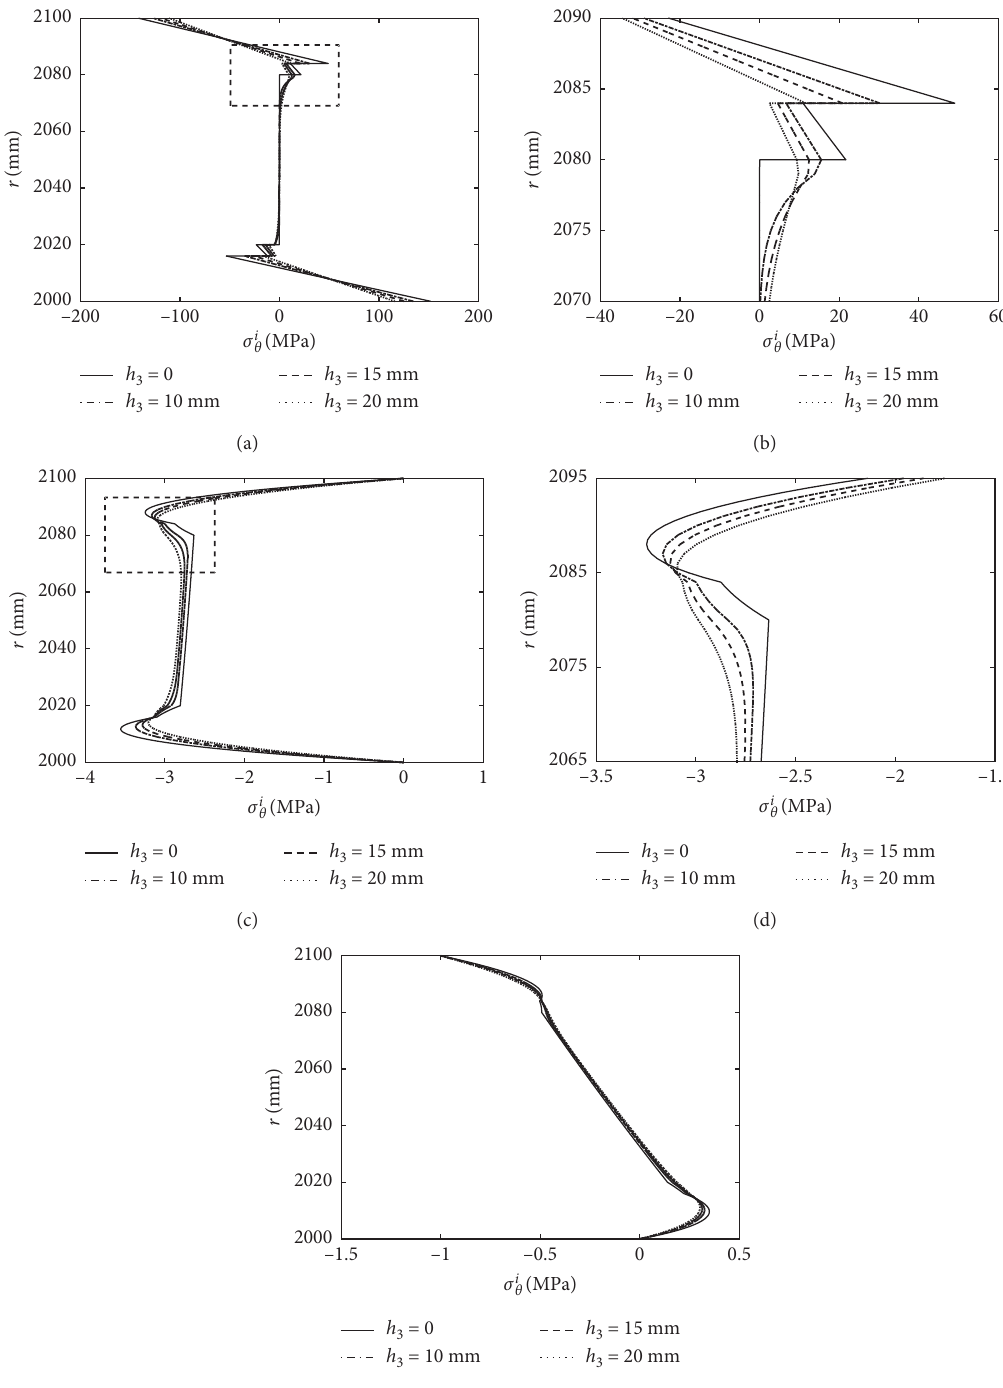
Figure 5: Stress distribution along the radial direction with different permeation thicknesses h θ � β /2. (b) Enlarged view of σ i